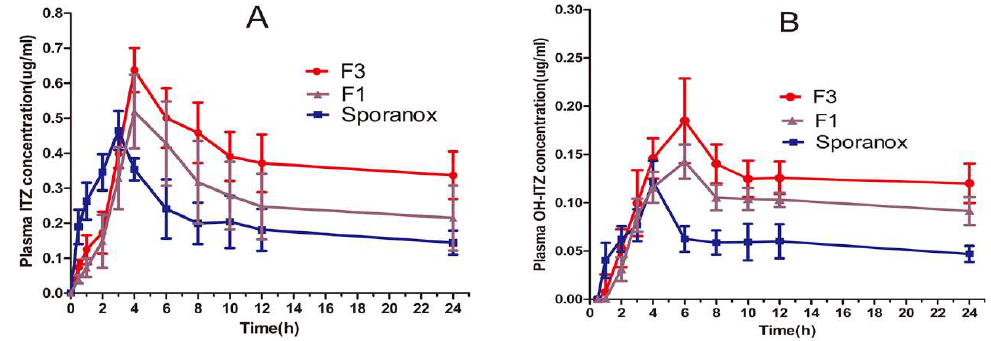
Figure 6. Plasma concentration–time profiles of ( A ) ITZ and ( B ) OH-ITZ after oral administration of the commercial capsules and the formulation of F1 (ITZ-HPMCAS) and F3 (ITZ-HPMCAS-15%TPGS). (Mean ± S.D., n = 6).